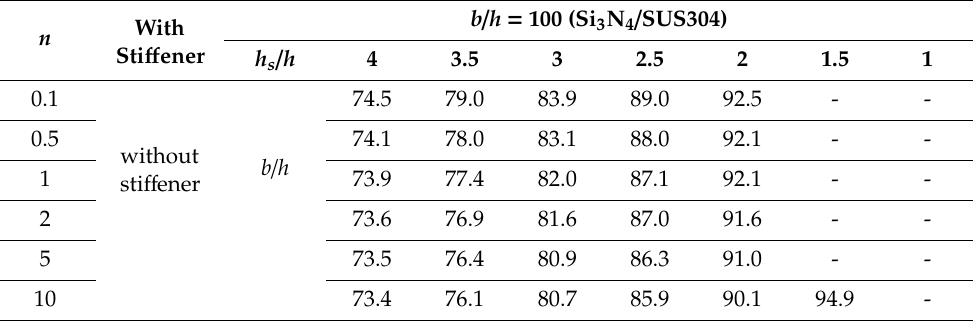
Table 5. The thickness relationship between Si 3 N 4 / SUS304 plate with and without a central sti ff ener ( b / h = 100).